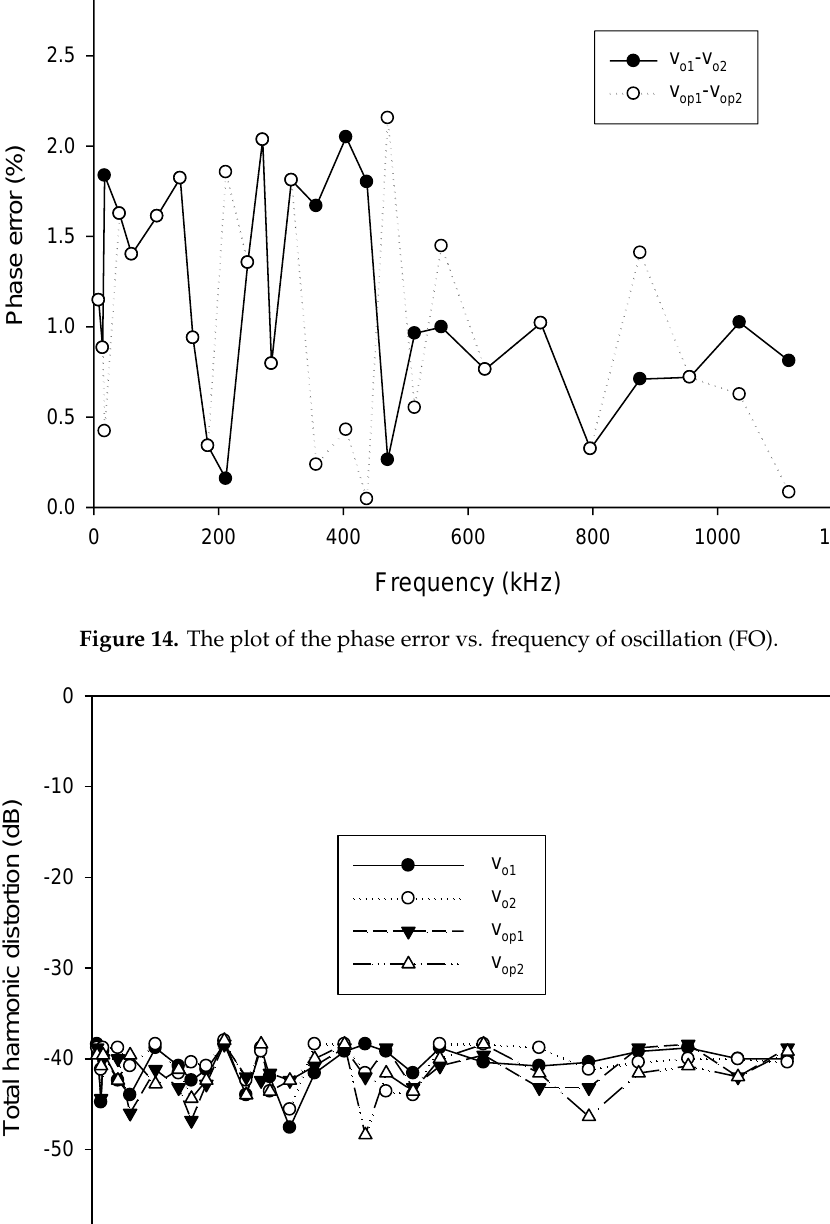
Figure 15. Total harmonic distortion of the quadrature output voltage waveforms.